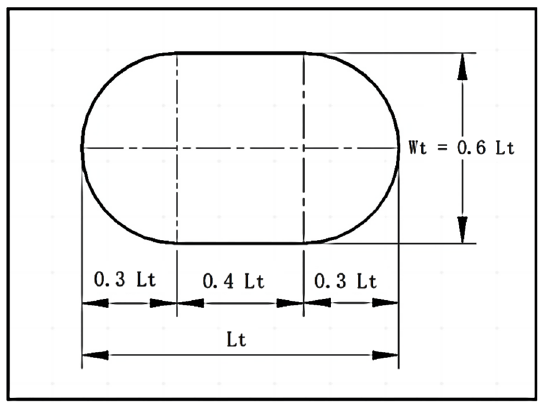
Figure 2. Schematic diagram of wheel print shape.